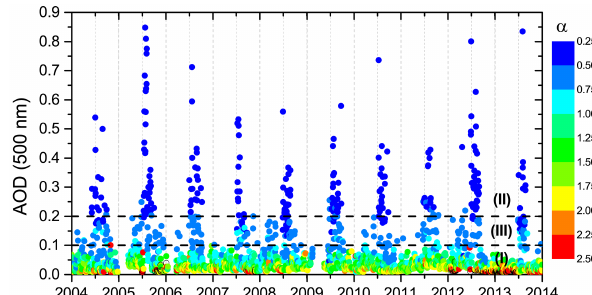
Figure 2. Daily AOD at 500nm time series from AERONET between 2004 and 2013 at IZO. The colour scale indicates the daily Ånsgtröm exponent ( α ) values. The dashed lines distin- guish the different AOD– α zones: (I) AOD ≤ 0.10 and α ≥ 0.75; (II) AOD ≥ 0.20 and α ≤ 0.50, and (III) 0.10 < AOD < 0.20 and 0.50 <α < 0 .